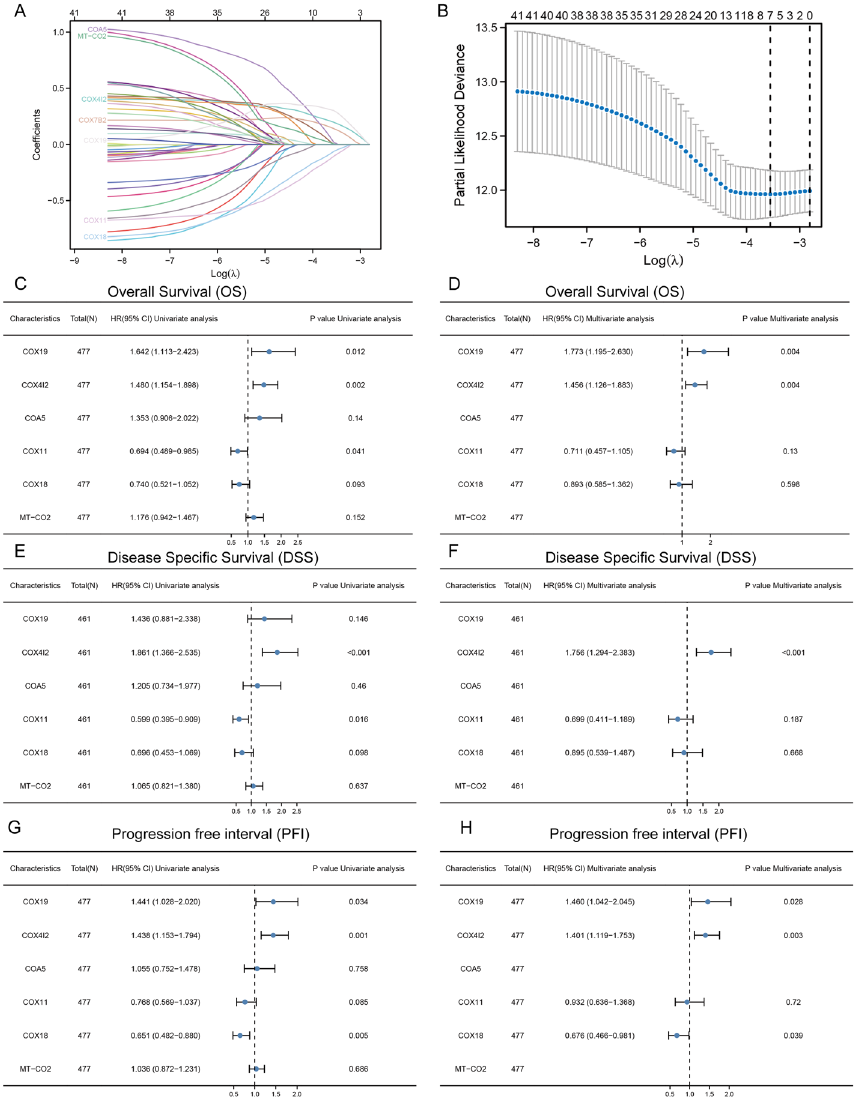
Fig. 1 LASSO and Cox regression models. a LASSO Cox model fitting. Each curve represents a gene. The profiles of coefficients were plotted versus log(λ). Vertical lines indicate the positions of 7 genes with coefficients > 0, as determined by tenfold cross‑validation ( n 480). b λ was determined from tenfold = cross‑validation. The x ‑axis represents log(λ); the y ‑axis represents binomial deviance. Optimal values calculated from minimum criteria and 1 SE of the criteria are indicated by the dotted vertical lines. c , d Univariate forest plot ( c ) and multivariate forest plot ( d ) showing association between COX expression and clinical features linked to OS in CRC ( n 477). e , f Univariate forest plot ( e ) and multivariate forest plot ( F ) = showing the association between COX expression and clinical features related to DSS in CRC ( n 461). g , h = Univariate forest plot ( g ) and multivariate forest plot ( h ) showing the association between COX expression and clinical features related to PFI in CRC ( n 477). CI Confidence interval, HR hazard ratio, SE standard error; = for other abbreviations, see Abbreviation